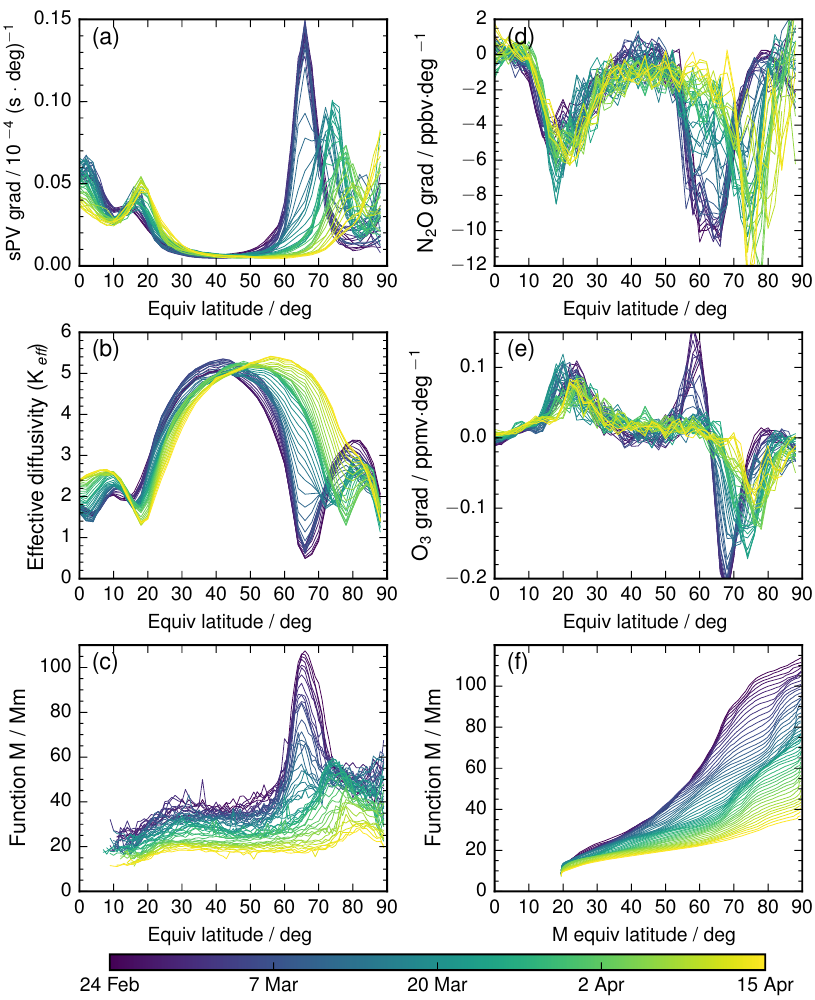
Figure 8. Equivalent latitude line plots of indicators of mixing and transport barriers at 490K showing individual dates from 24 February through 15 April (see color bar). The panels show (a) sPV gradients, (b) K eff , (c) the function M , (d) EqL gradients in N 2 O, (e) EqL gradients in ozone, and (f) M as a function of M -based equivalent latitude ( M -EqL). Quantities in panels (a) through (e) are all functions of PV-based EqL; panel (f) is the only exception. Note that the units of M are in megameters (Mm, 10 6